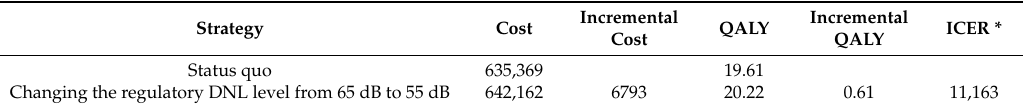
Table 2. Costs (2016 U.S.$), incremental cost, quality-adjusted life years (QALYs) gained, incremental QALYs gained, and incremental cost-effectiveness (ICER) of changing the regulatory day–night average sound level (DNL) from 65 decibels (dB) to 55 dB versus the status quo.